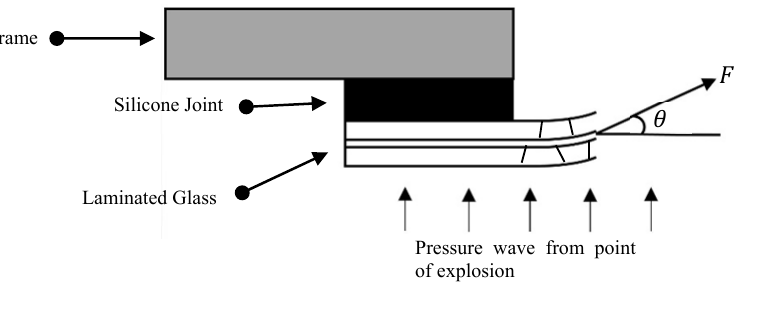
Fig. 1 A simplified illustration of the application of structural